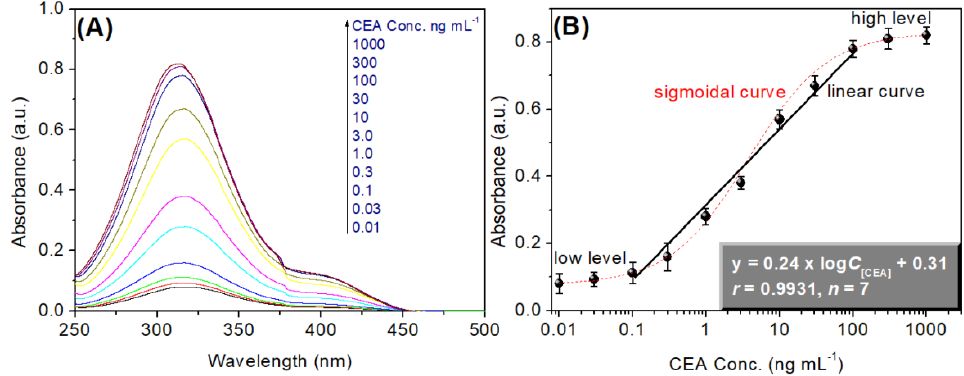
Figure 5. ( A ) UV–vis absorption spectra of the obtained supernatants after the aptasensing platform reacted with CEA standards of different concentrations; ( B ) the corresponding calibration plots. (Note that each data point represents the average value obtained from three measurements. The error bars represent the 95% confidence interval of the mean for y-axis concentrations.)